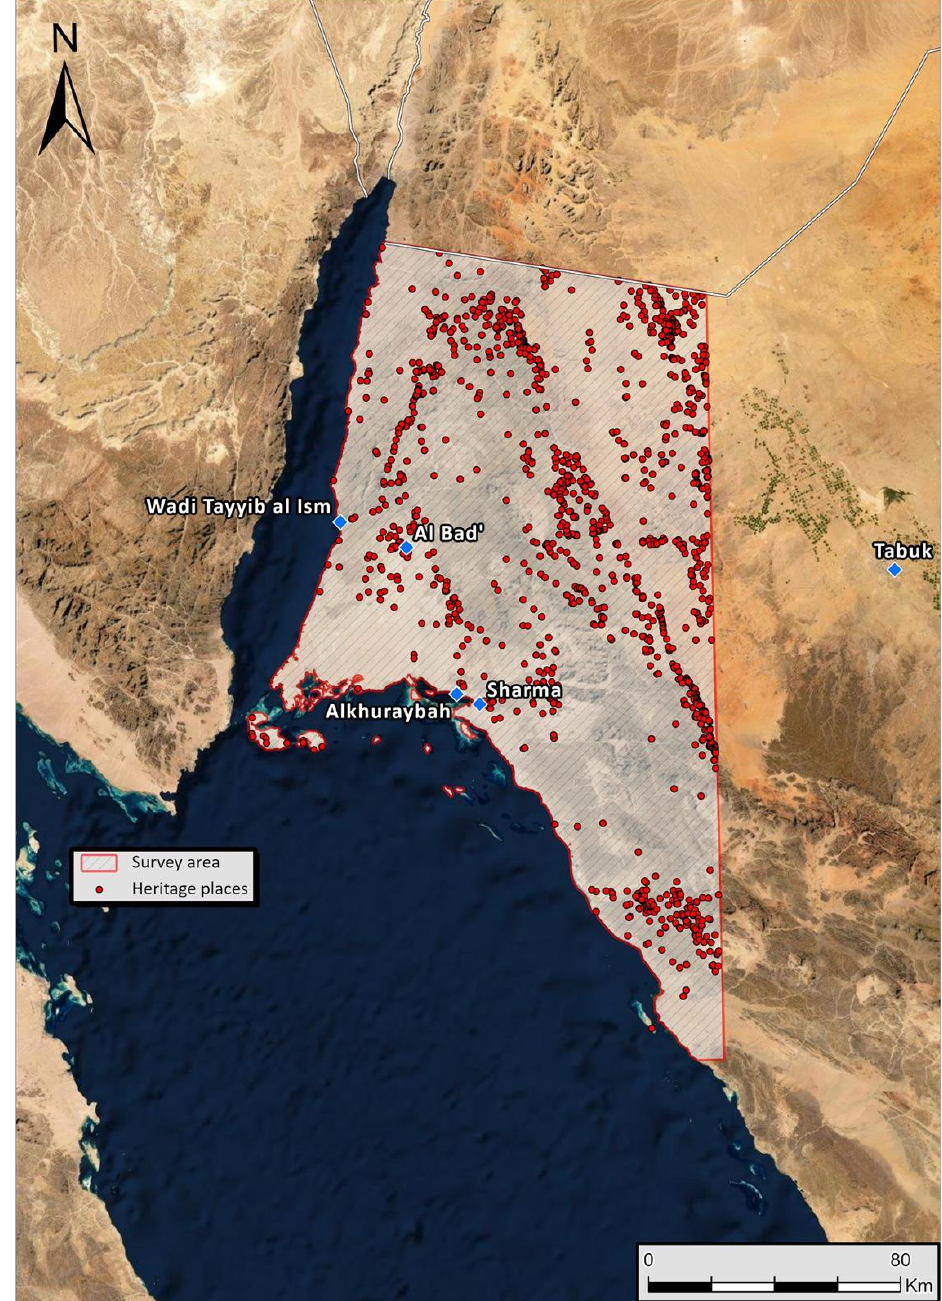
Figure 5. Distribution of all potential sites recorded via remote sensing survey.